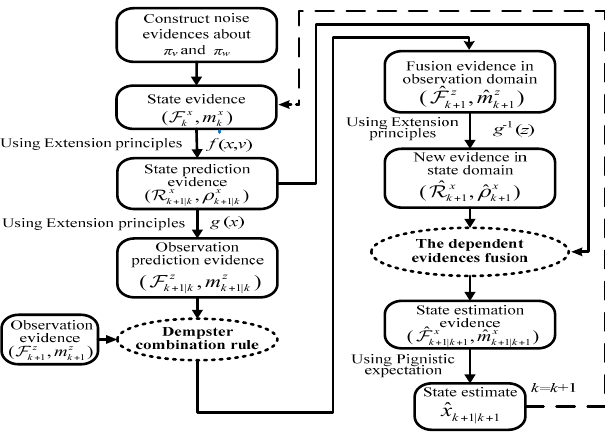
Figure 3. Flowchart of state estimation iterative algorithm.